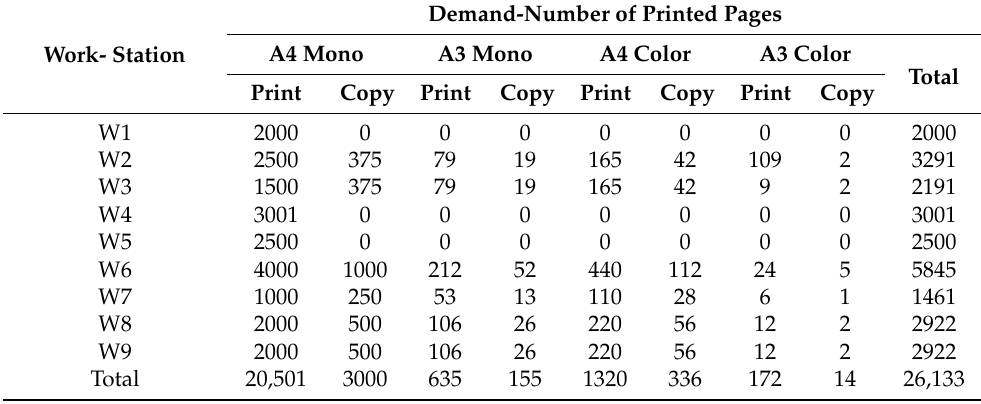
Table 2. Demand for different types of printouts.